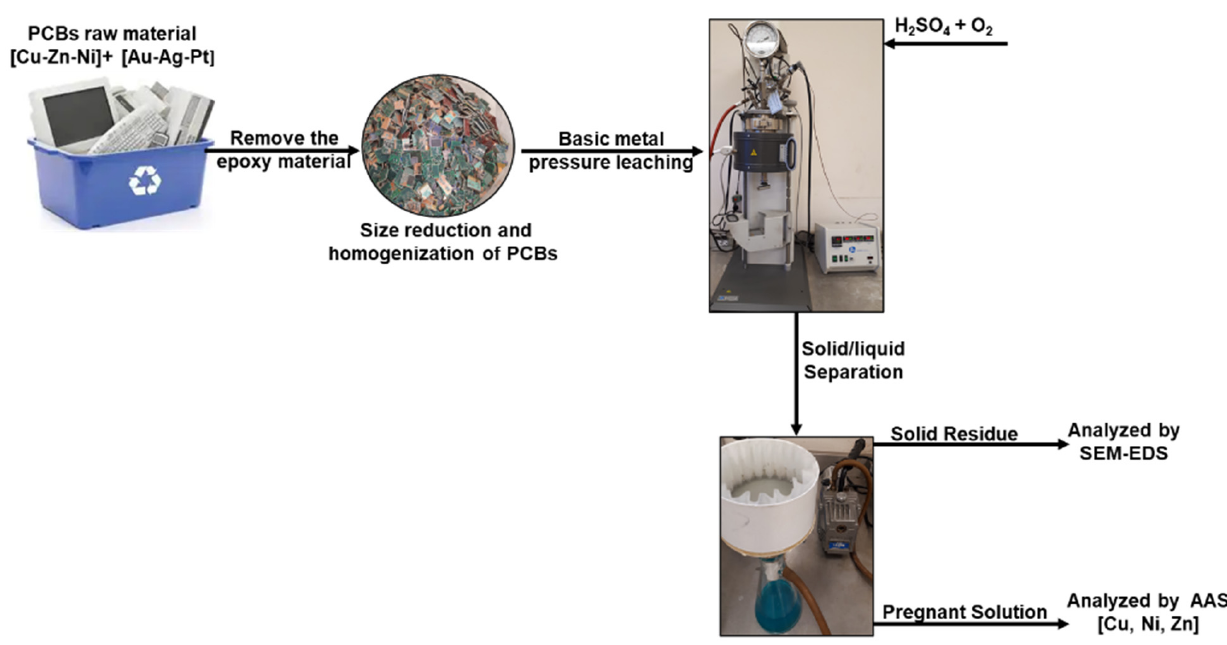
Figure 1. Flowsheet of Cu, Zn, and Ni leaching from PCBs.